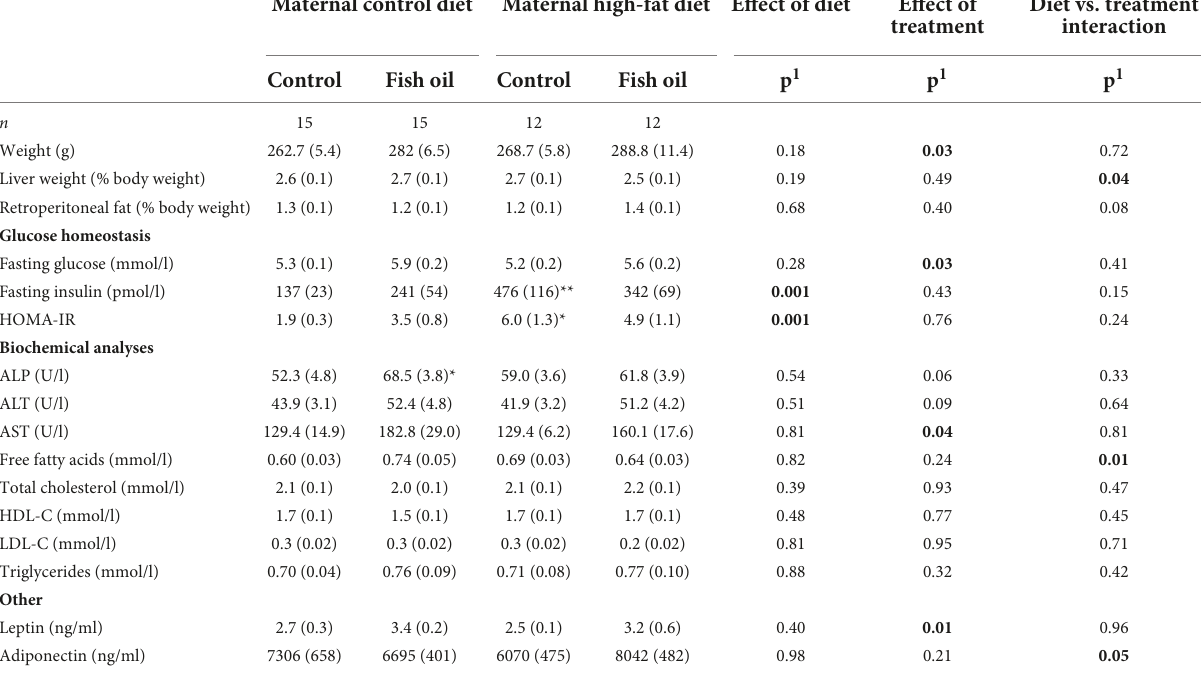
Diet vs. treatment treatment interaction